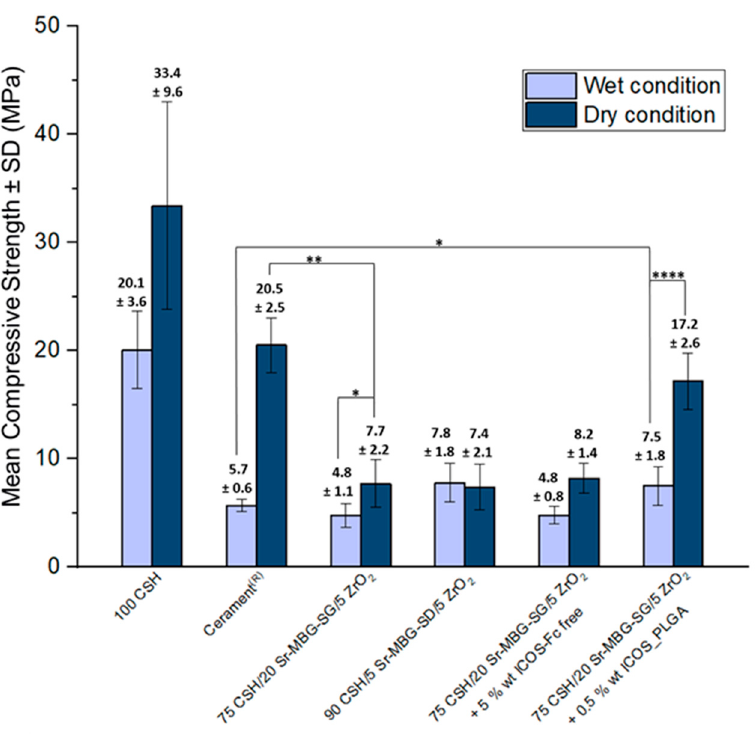
Figure 4. Compressive strength values of the investigated formulations measured in accordance with the ISO 5833-2022 standard under wet and dry conditions (i.e., after 24 h and 7 days of setting at 37 °C, respectively). (* p<0.05, ** p<0.01, *** p<0.005, **** p<0.0001).